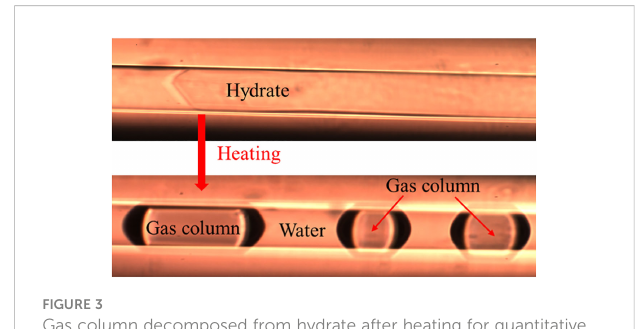
FIGURE 3 Gas column decomposed from hydrate after heating for quantitative Raman spectroscopic